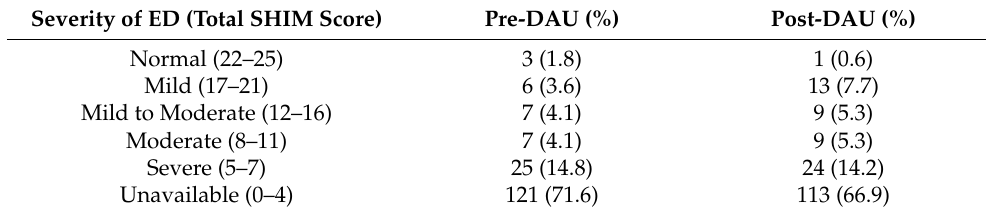
Table 7. Distribution of